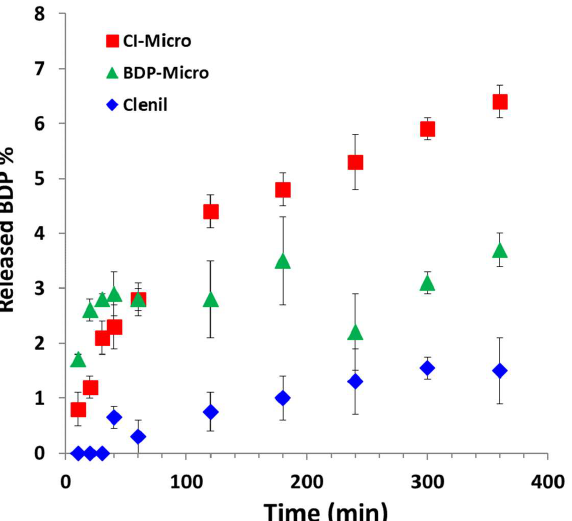
Figure 4. Cumulative release profiles from CI-Micro and BDP-Micro samples and from Clenil ® , at 37 °C by using vertical Franz-type diffusion cells. Data represent mean ± S.D. ( n = 3).